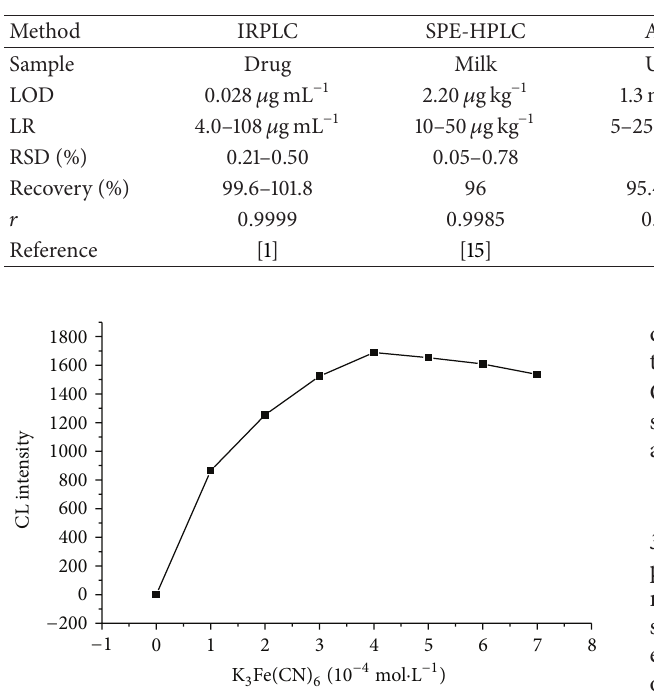
Figure 5: Effect of K 3 Fe(CN) 6 concentration on CL intensity. Con- dition: [ENRO] = 2.0 × 10 −6 g ⋅ L −1 , [luminol] = 8.0 × 10 −5 mol ⋅ L −1 , luminol in 0.2 mol ⋅ L −1 NaOH